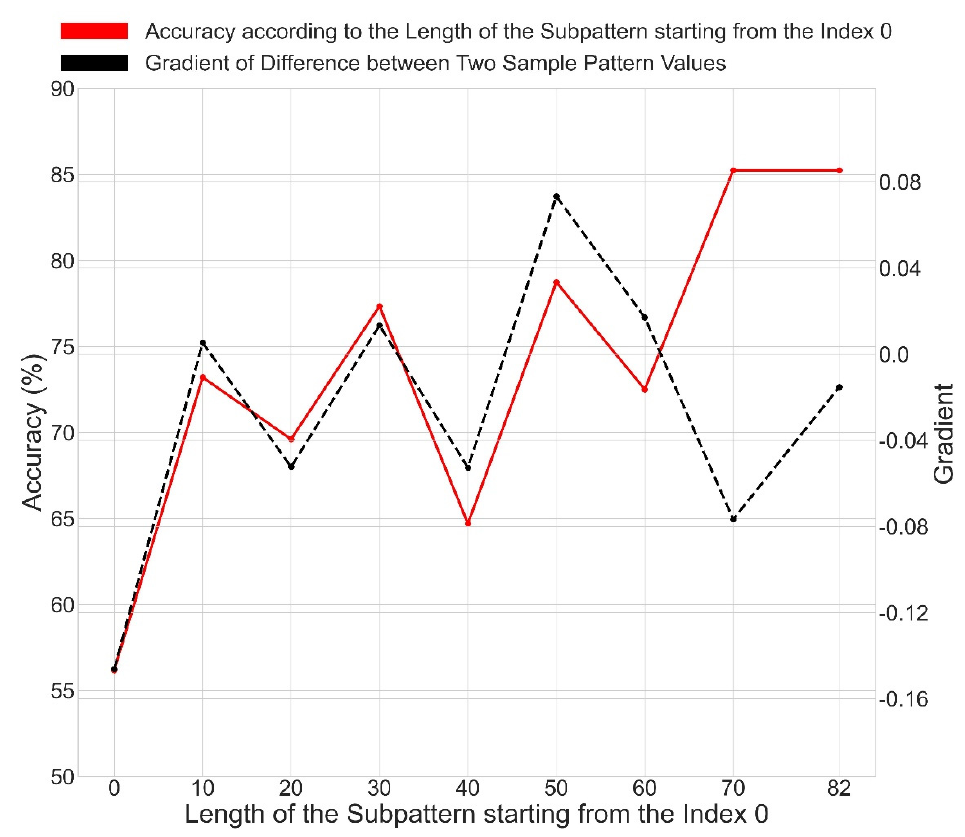
Figure 13. Accuracy (red) and gradient of differences between values of representative patterns of each class (black) according to the length of the subpattern starting from the index 0 for the TwoLead dataset, which is a general ECG classification task not related to heart disease. Table 9. Performance evaluation of SDK-Injection among various length of shallow domain knowledge on the non-disease ECG.